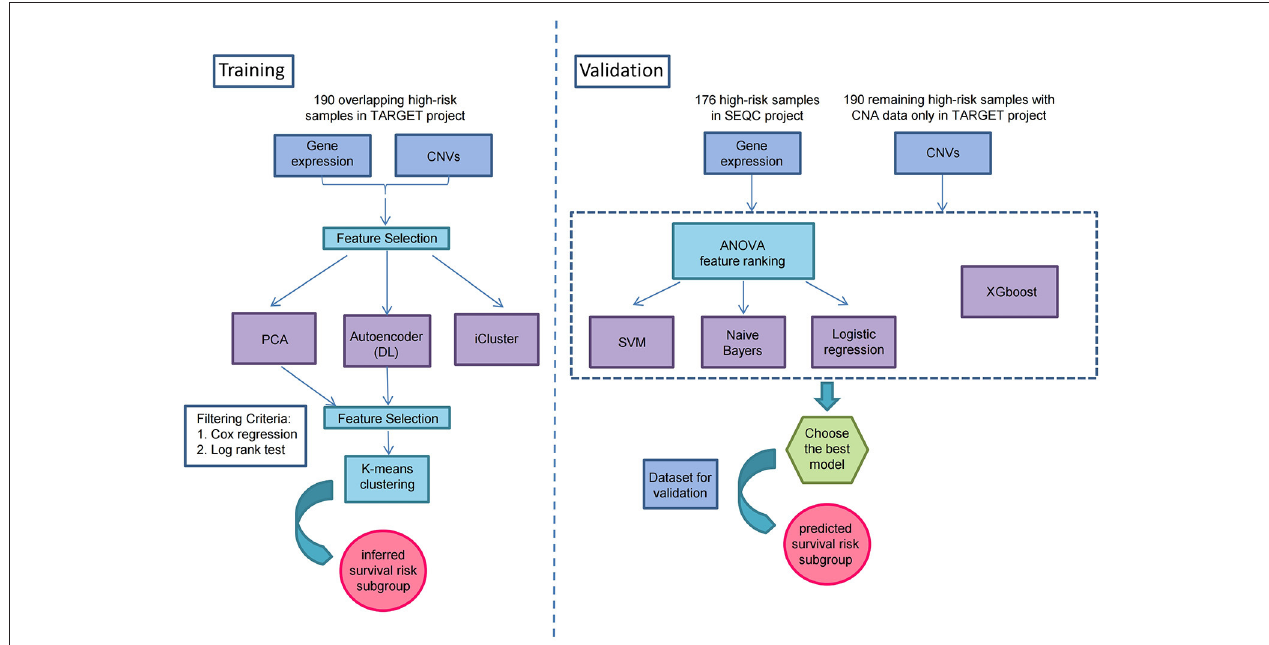
FIGURE 1 | Overview workflow for the identification of prognostic subtypes by Autoencoder-based multi-omics data integration in high-risk neuroblastoma.